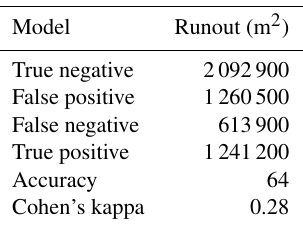
Table 5. Confusion matrix for the landslide runout prediction in Hongchun watershed.